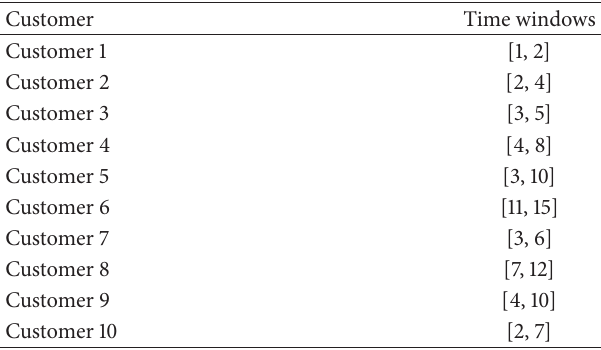
the population size, crossover rate, mutation rate, and max iteration were set to 50, 0.8, 0.4, and 500, respectively. The example case was solved and repeated 30 times, and the average CPU time was 102 seconds. The best results for the GA are listed in Tables 5 and